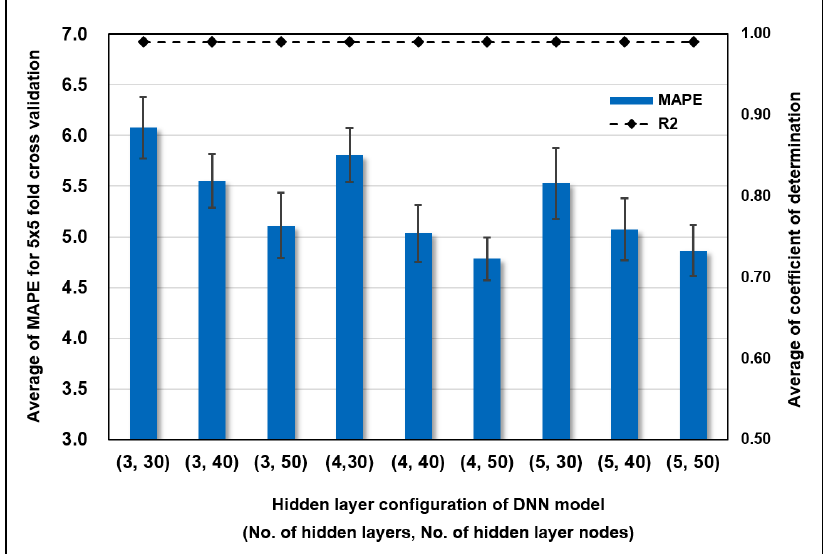
Figure 9. Results of 5 × 5-fold cross validation for predicting ore production during morning.